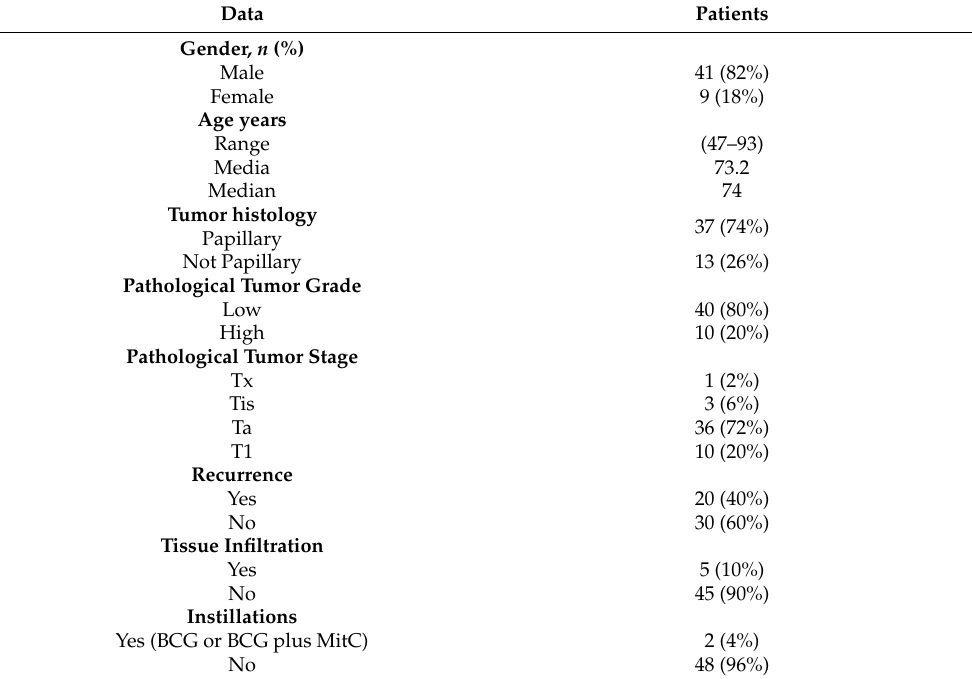
Table 1. Patients’ demographic and clinical characteristic and classification based on WHO 2017 criteria.